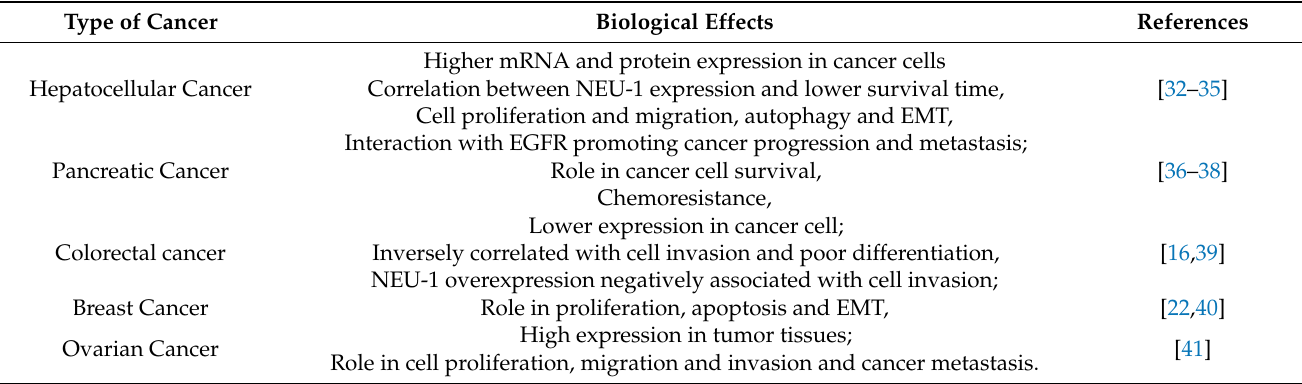
Table 1. Examples of NEU-1 implication in